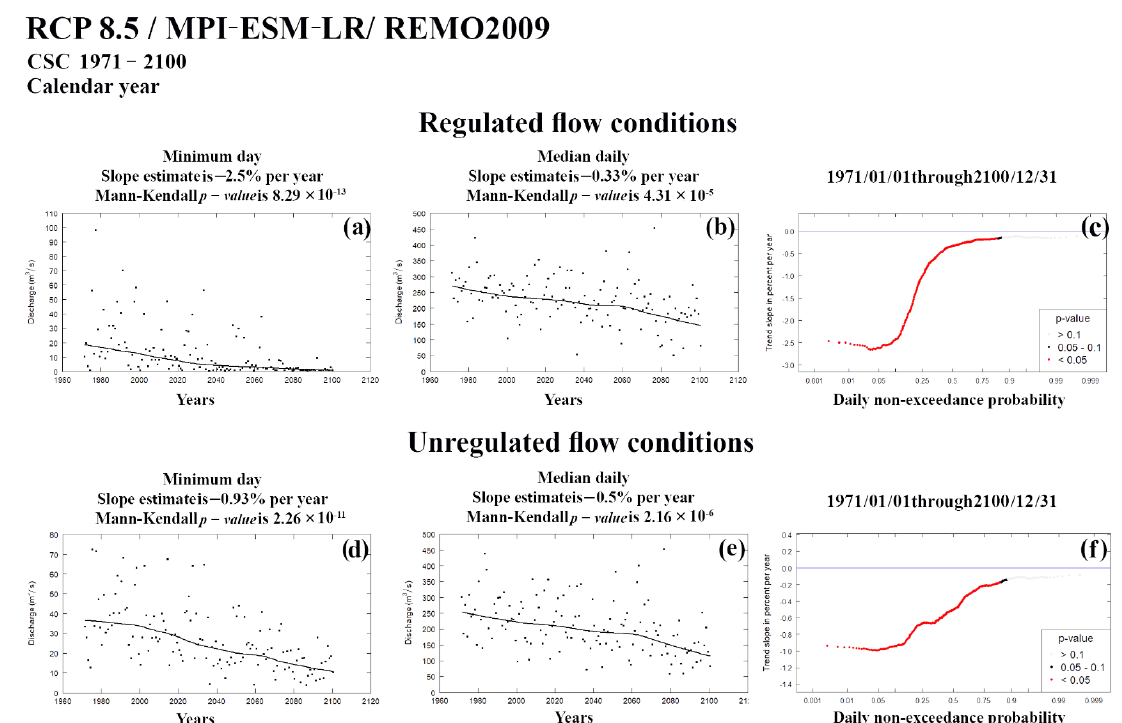
Figure 7. FlowTrend Plots from the combination RCP 8.5/MPI − ESM − LR/REMO2009 for annual simulated daily stream- flow for regulated conditions: ( a ) minimum day, ( b ) median day, ( c ) Quantile − Kendall plot, and for unregulated conditions: ( d ) minimum day, ( e ) median day, ( f ) Quantile − Kendall plot.